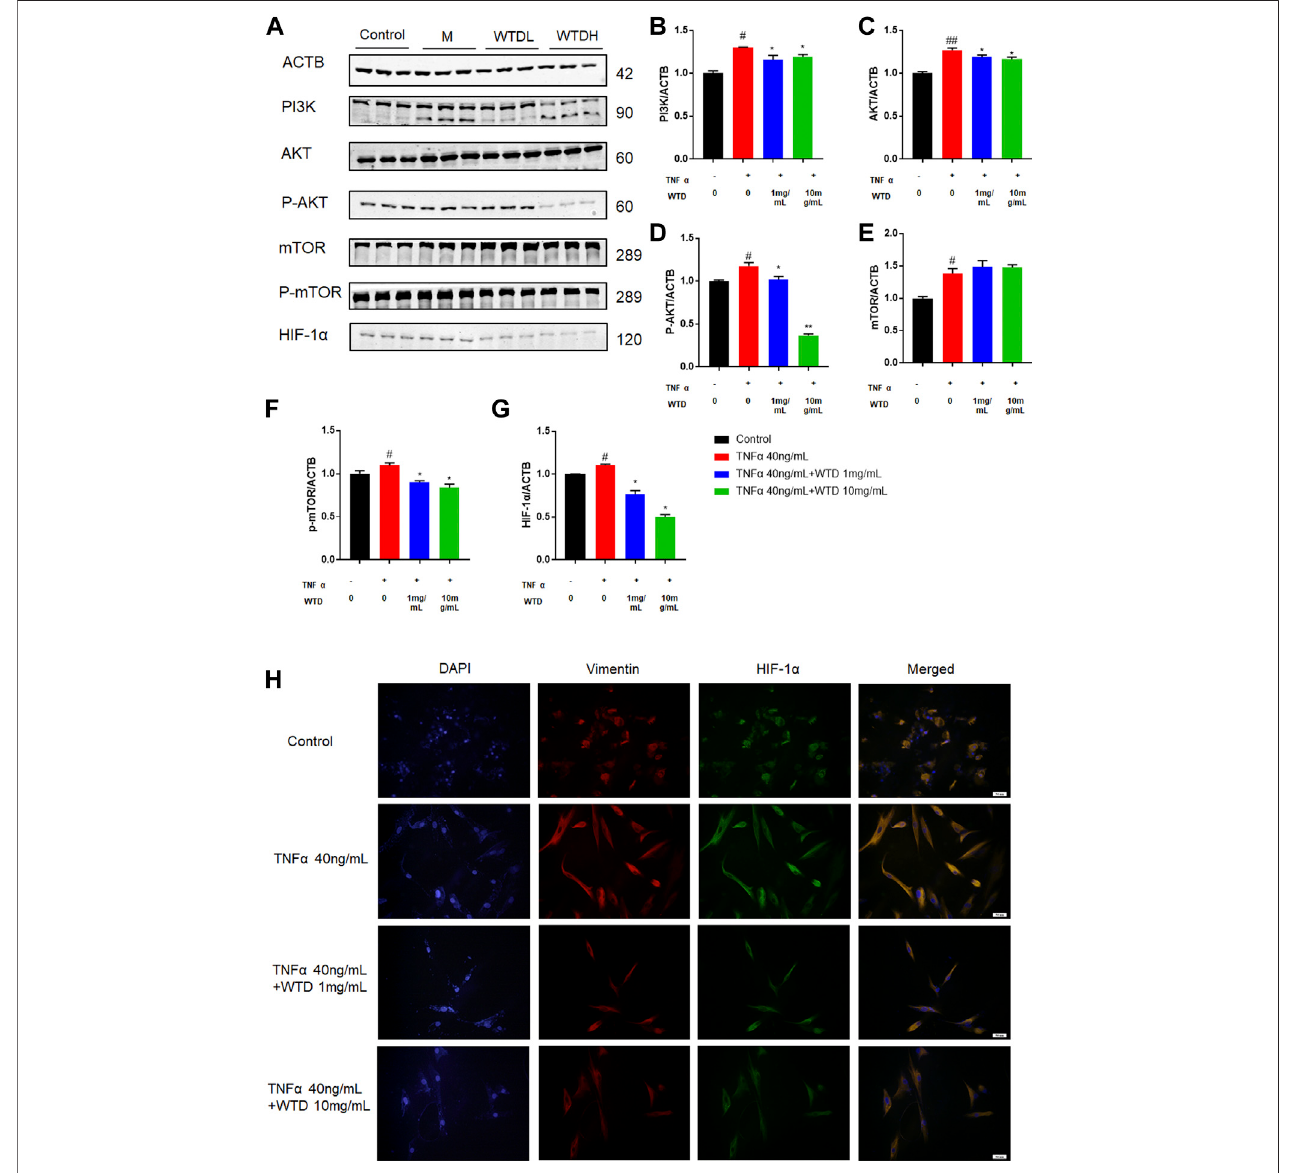
FIGURE 8 | The effects of WTD on the PI3K-AKT-mTOR-HIF-1 α pathway in vitro . (A) Representative western blots showing the components of the PI3K-AKT- mTOR-HIF1 α pathway after WTDtreatment in MH7A cells. M: TNF α 40 ng/ml; WTD-L: TNF α 40 ng/ml + WTD 1 mg/ml; WTD-H: TNF α 40 ng/ml + WTD 1 mg/ml (B – G) Quantitative analysis of the western blots after WTD treatment in MH7A cells. (H) Representative immuno fl uorescence staining for HIF1 α in MH7A cell sections. The results are expressed as mean ± SE. # p < 0.05, ## p < 0.01versus the Control group; * p < 0.05, ** p < 0.01 versus the TNF α 40 ng/ml group. ACTB, β -actin; PI3K, Phosphatidylinositide 3-kinases; AKT, protein kinase B; p-AKT, Phosphorylated protein kinase B; mTOR, Mammalian target of rapamycin; p-mTOR, Phosphorylated Mammalian target of rapamycin; HIF-1 α , Hypoxia-induced factor 1 α .